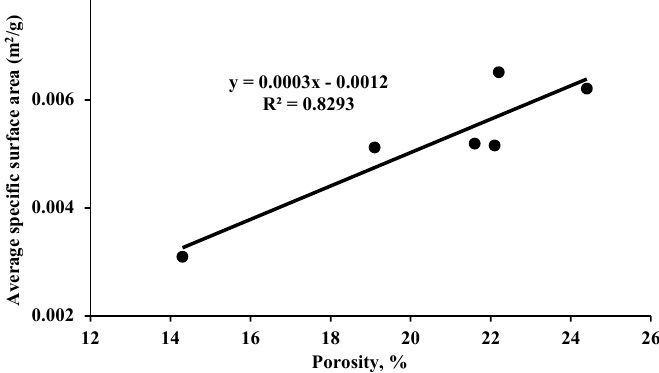
Figure 6. The relationship between SSA and porosity at different SC-CO 2 treatment pressures [55].